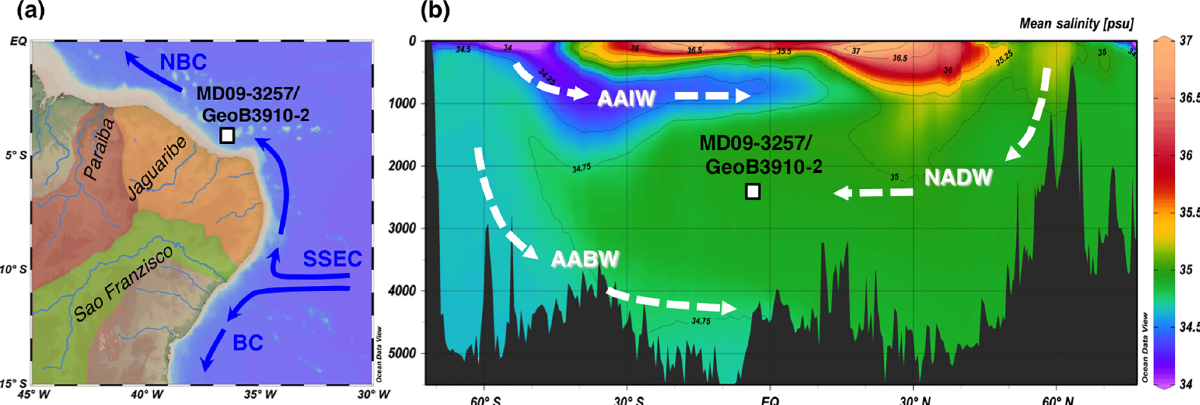
Figure 1. (a) Map showing the position of the main Brazilian rivers and surface currents that could influence the terrigenous input at the study site; the study site is indicated by a white square. The orange area represents the catchment area of the local rivers directly delivering sediments to the study site, and the green area represents the catchment area of the Sao Franzisco River (Milliman et al., 1975). NBC stands for North Brazil Current, SSEC stands for Southern South Equatorial Current and BC stands for Brazil Current. (b) Salinity section showing the core site and the main water masses in the modern Atlantic Ocean. NADW stands for North Atlantic Deep Water, AAIW stands for Antarctic Intermediate Water and AABW stands for Antarctic Bottom